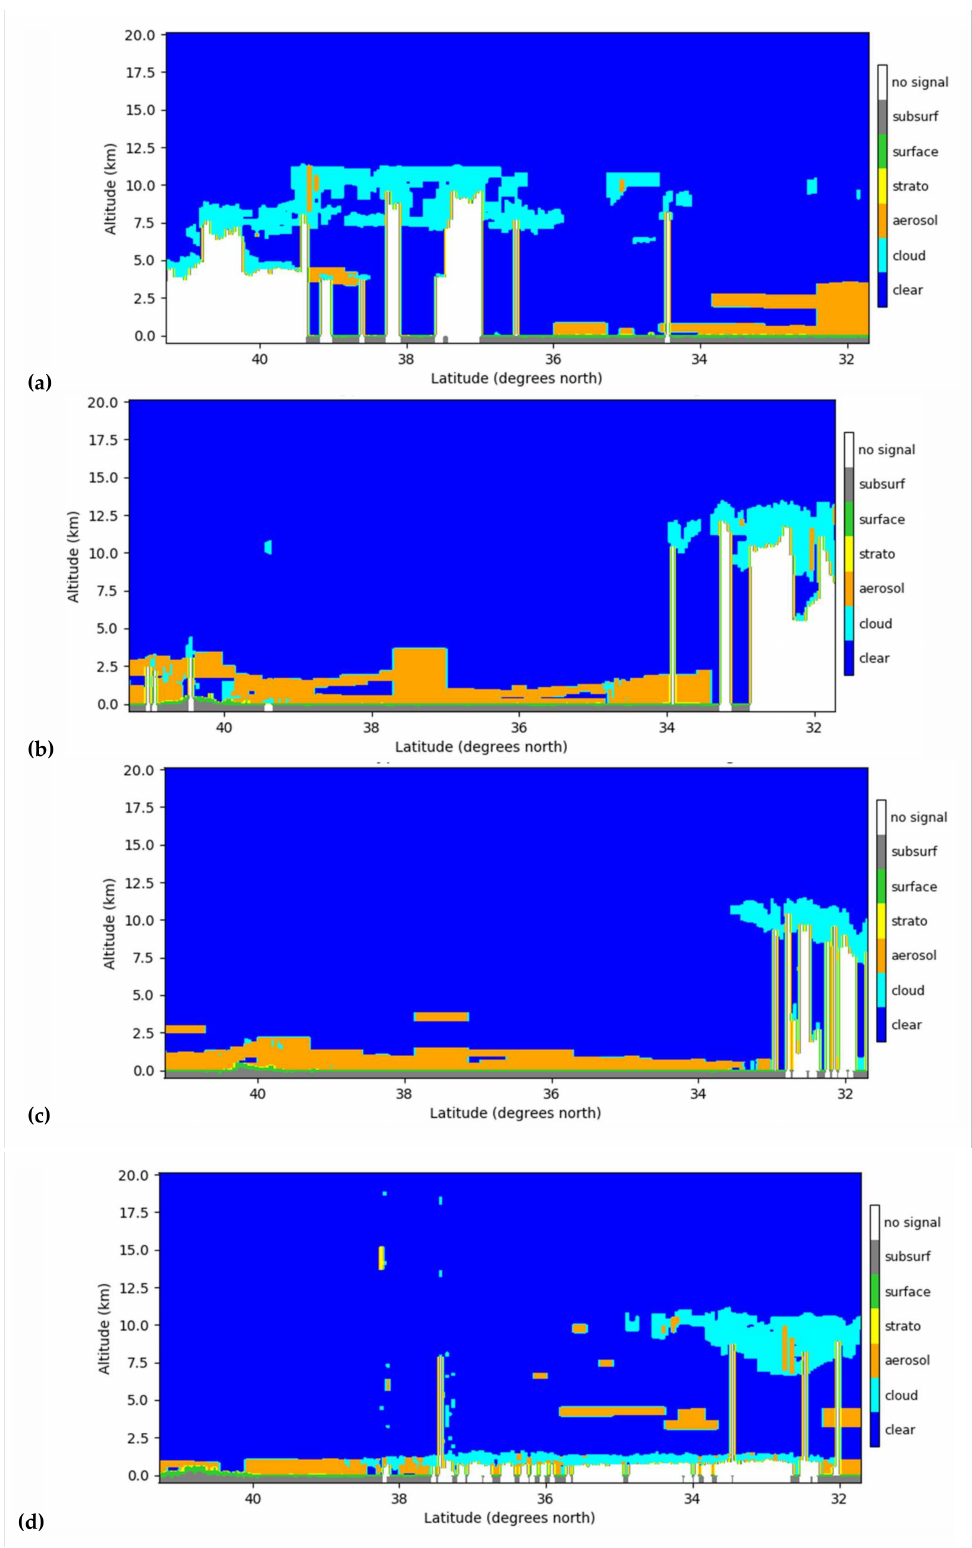
Figure 10. CALIPSO VFM plots on cases in Figure 8, ( a ) 25 March 2020 05:14 UTC; ( b ) 15 July 2020 05:21 UTC; ( c ) 26 September 2020 05:27 UTC; ( d ) 16 January 2021 05:28 UTC. The legends of no signal, subsurf, surface, strato, aerosol, cloud, and clear denote no signal (complete signal attenuation), subsurface, surface, stratospheric aerosol, tropospheric aerosol, cloud, and clear air,